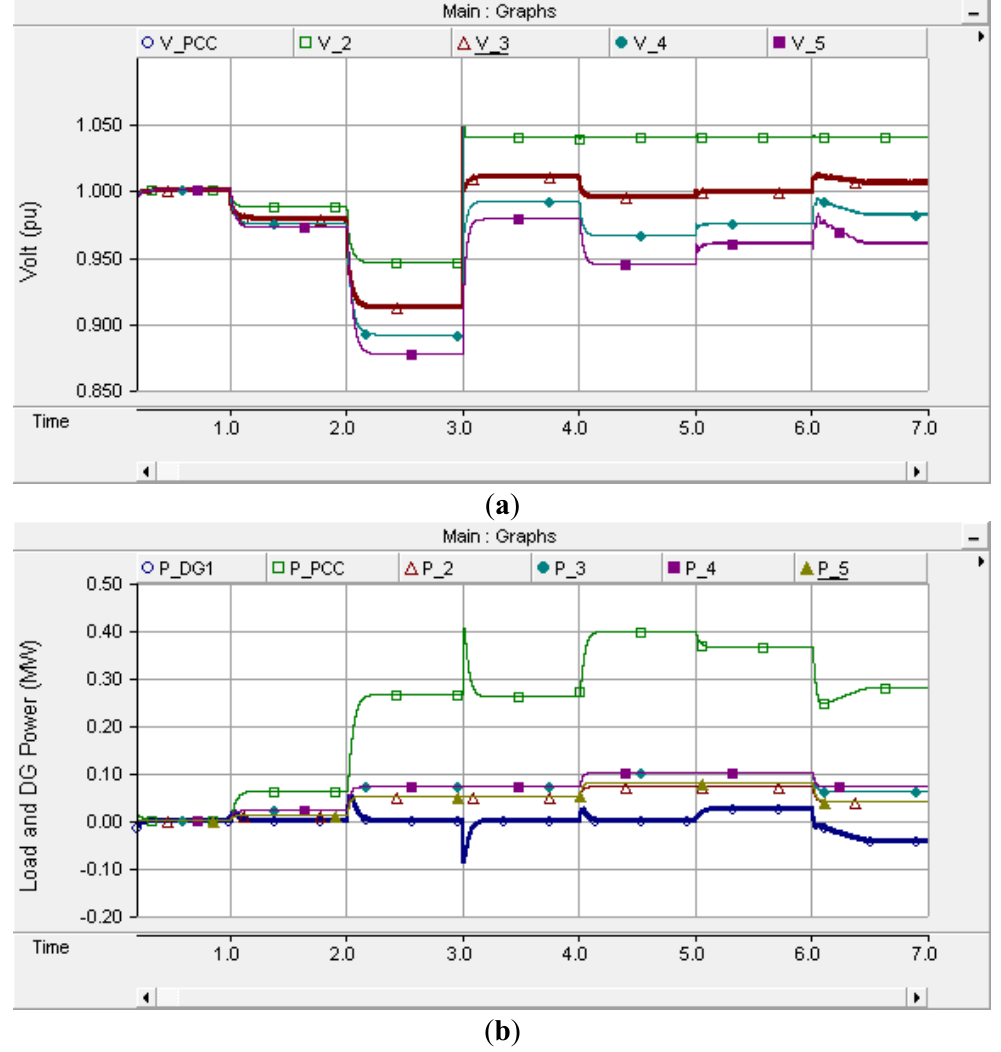
Figure 7. ( a ) Result of simulation scenario: Bus Voltage; ( b ) Result of simulation scenario: Injected power from the DG at Bus 5.